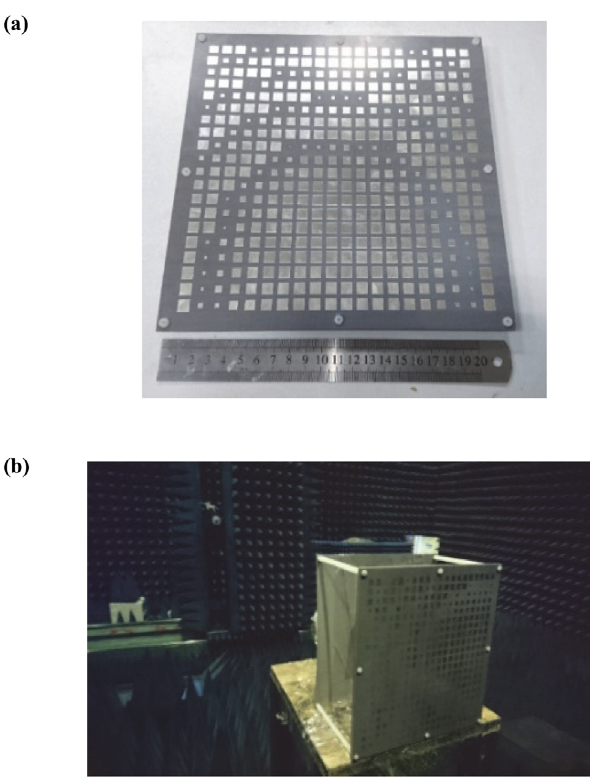
Fig. 15. (a) Top view of the antenna (HAT2), and (b) measurement environment for HTA2 in the microwave anechoic chamber.